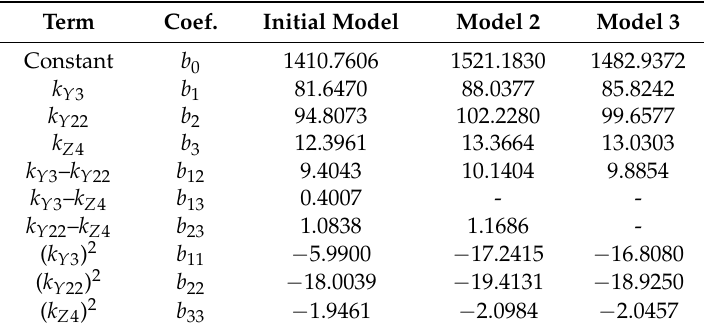
Table 9. Significance of individual regression coefficients: t -statistic.